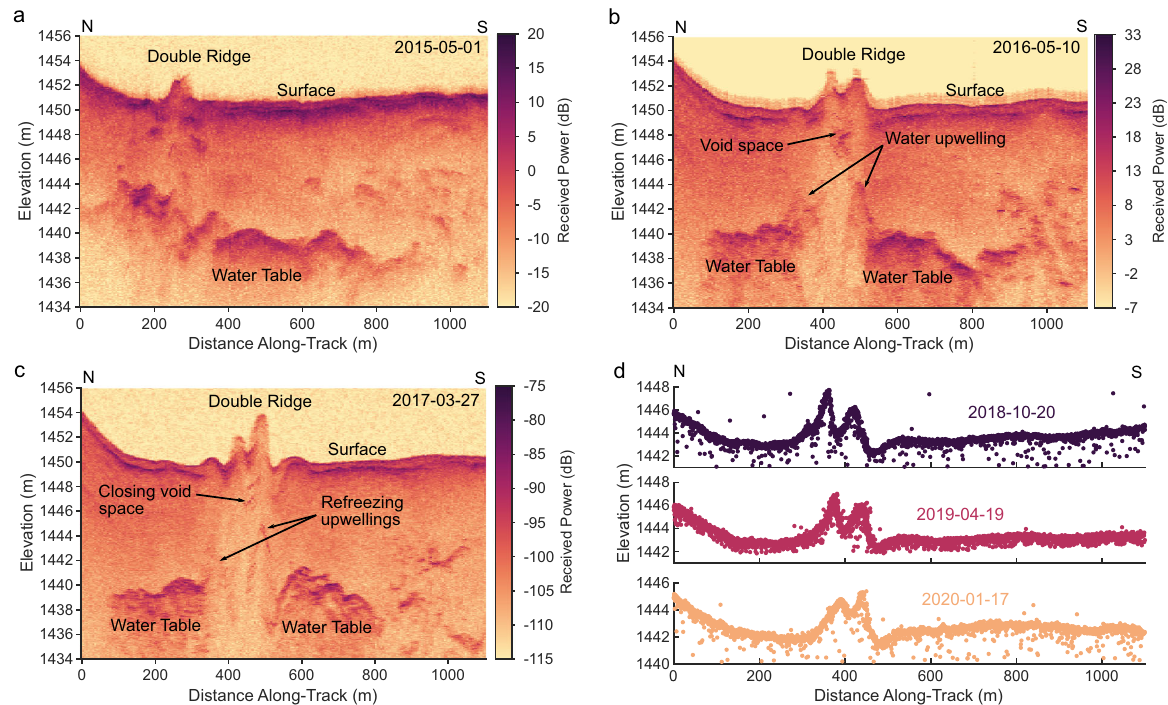
Fig. 3 Time series of high-resolution radargrams and ICESat-2 laser altimetry showing the evolution of the double ridge system. In panels a – c , the color scale shows the relative received radar power with darker colors indicating stronger returns. In panel d , the surface elevation pro fi les are color-coded by collection date. a Radargram collected in May 2015. The water table is continuous and the southern ridge has not yet developed. b Radargram collected in May 2016. This radargram shows the full double ridge, underlain by the divided and upwelling water table, along with scattering from likely void space beneath the central trough. c Radargram collected in March 2017. The system morphology remains generally stable, with reduced re fl ectivity in the upwelling water table and void spacing, suggesting freeze-out and creep closure. d ICESat-2 surface elevation pro fi les collected over the ridge in October 2018 (dark purple), April 2019 (light purple), and January 2020 (orange). These plots show high-quality (level 4) photons from ground track 331. Apparent changes in ridge cross-section may be the result of along-strike variations in ridge structure as the ridge is advected ~106 ma − 1 under the fi xed satellite track.